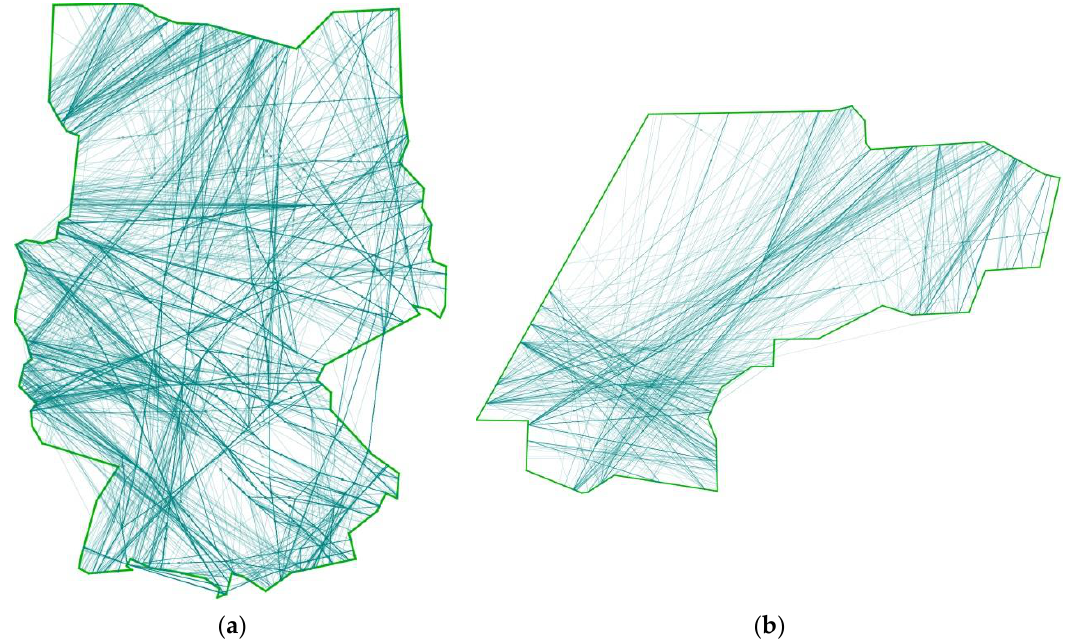
Figure 9. German airspace boundary ( a ) and EDYYDUTA ( b ) with flown trajectories as turquoise lines. The darker the color the more flights use the corresponding part of the airspace.